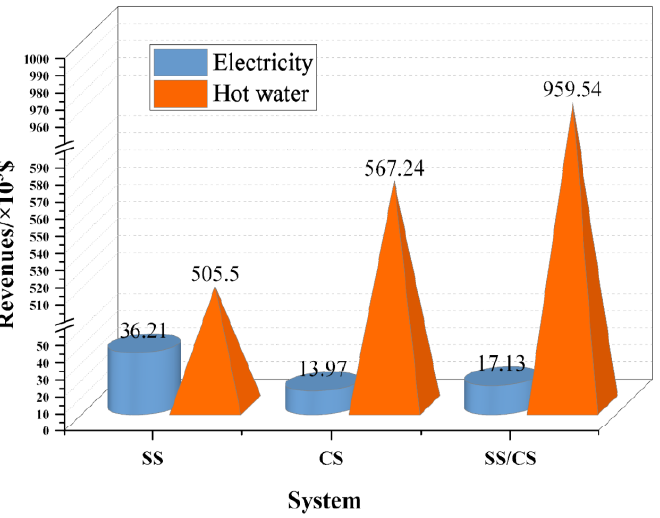
Figure 17. The electricity and hot water revenues of the three systems.